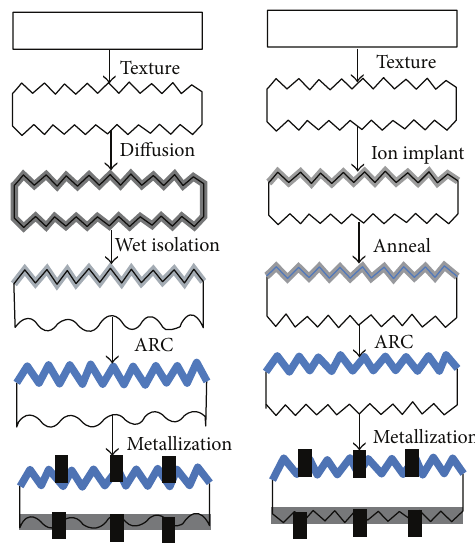
Figure 2: Process flow comparison of conventional and ion- implanted solar